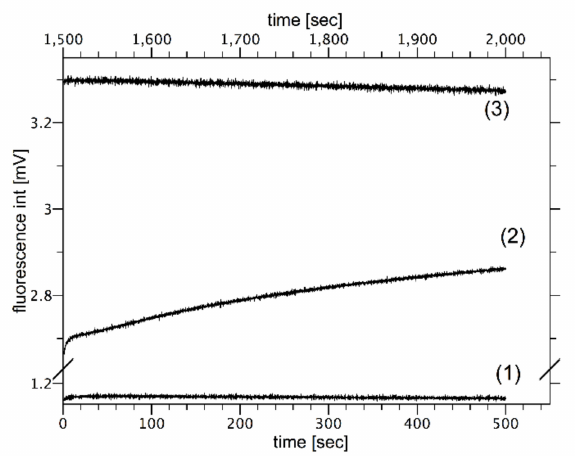
Figure 8. The kinetics of fluorescence intensity change for egg-PC vesicles labeled with fluorescein-PE exposed to the pH gradient ∆ pH = 1.4 (kinetic 2) and at ∆ pH = 0 (kinetic - 1) are presented. Plot 3 is plot 2 monitored in a different time interval (upper scale) showing the extant of the photo-bleaching effect. The pH gradient was generated by mixing vesicle suspension at pH 6.20 with buffer at pH 9 at proportions ensuring the desire pH